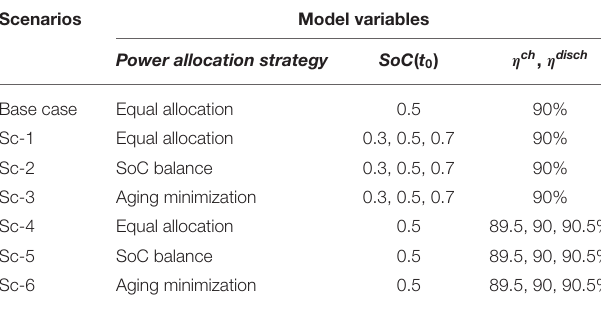
TABLE 1 | Simulation scenarios considering different power allocation methods and BESS’s properties.